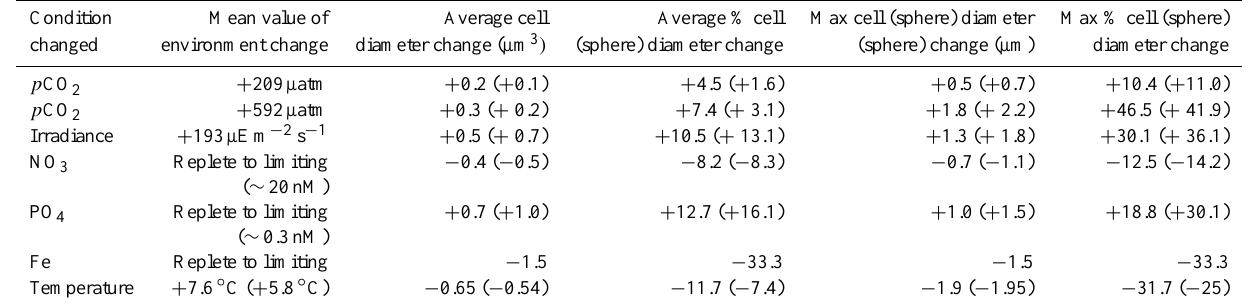
Table 4. Changes in cell and coccosphere (sphere) diameter for given changes in environmental conditions in culture experiments. Condition Mean value of Average